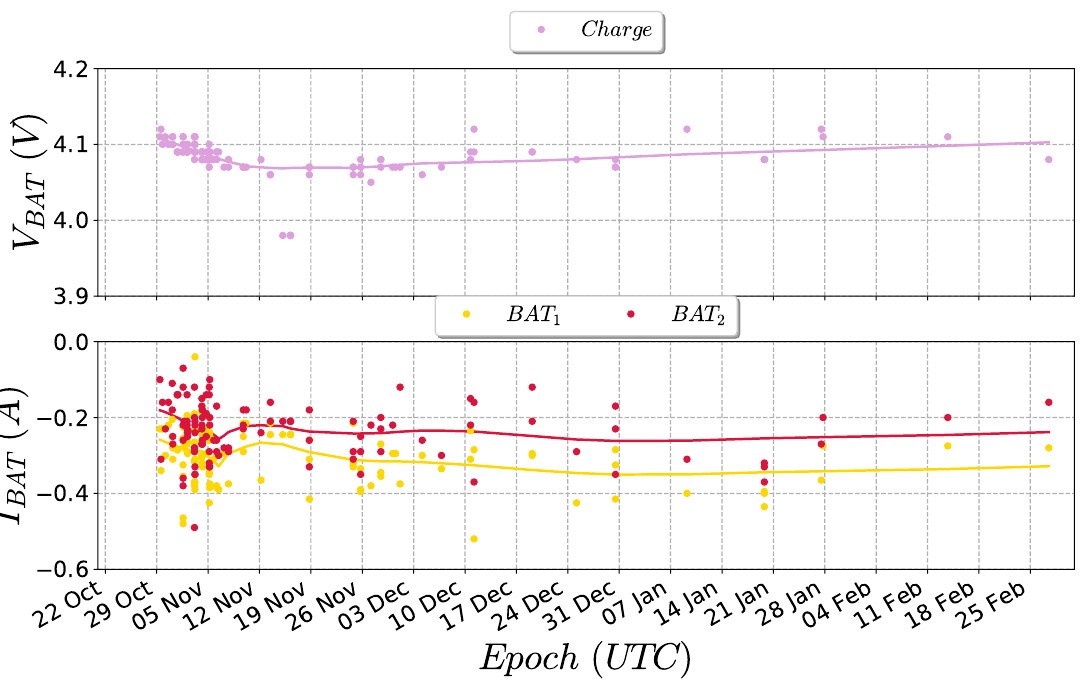
Figure 14. Time series of the battery voltage and the charge currents of both Ten-Koh batteries recorded since the launch. The LOWESS regression through the time series is also shown. Negative current has been defined to be charging the